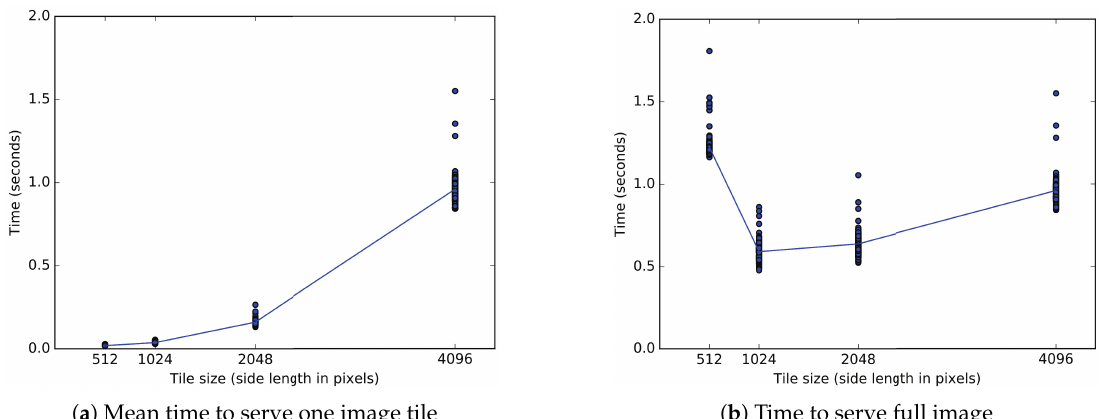
Figure 11. One experiment uses two metrics measured in seconds to evaluate tiled image transfer to an OpenSeadragon client. ( a ) The time to send a single client tile depends on the size of the tile and the bit rate. The sides of a single square tile range from 512 to 4096 pixels. Tiles of the two smaller sizes each arrive in less than 40 ms. Tiles measuring 2048 and 4096 pixels per side each arrive in approximately 160 ms and 960 ms, respectively. ( b ) Only the bit rate affects the time to send a full tiled image of 4096 pixel sides. Sending the full section in one tile of 4096 × 4096 pixels takes 960 ms, but a division into 64 square tiles of 512 × 512 pixels increases that time to 1200 ms. Tiles of 1024 and 2048 pixel sides reduce the time to 590 ms and 640 ms,